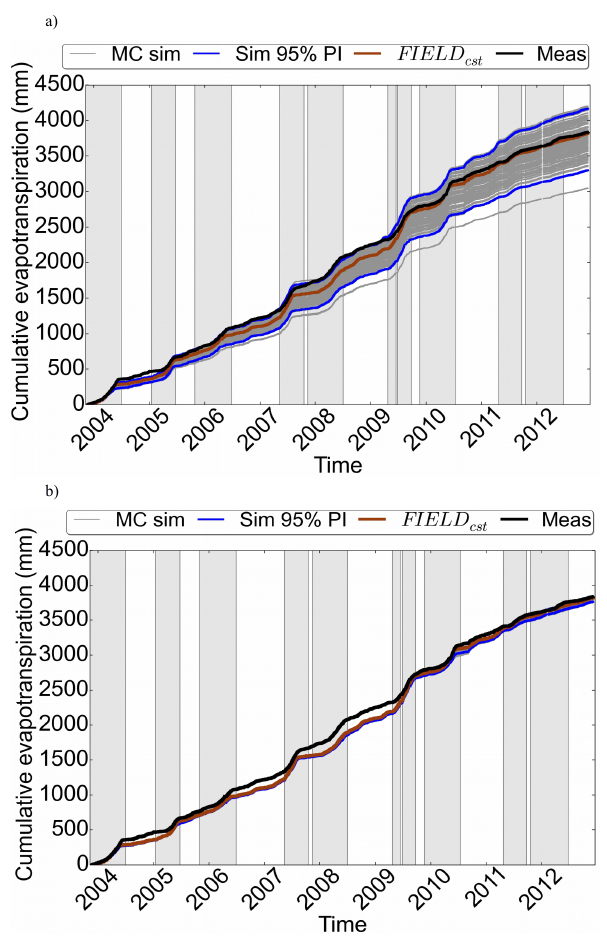
Figure 8. Propagation of the uncertainties in (a) the soil parame- ters ( Z root-zone , θ s , θ fc , θ wp ) and (b) the mesophyll conductance, on simulated ET. FIELD cst is the simulation achieved with the mean values of Z root-zone , θ s , θ fc , θ wp derived from the field measure- ments of soil moisture and the standard value of gm (Gibelin et al., 2006). The grey curves represent the 100 simulations generated by the Monte Carlo (MC) scheme. The 95th percentile interval (PI) of the MC simulations is computed over the empirical distributions of cumulative ET